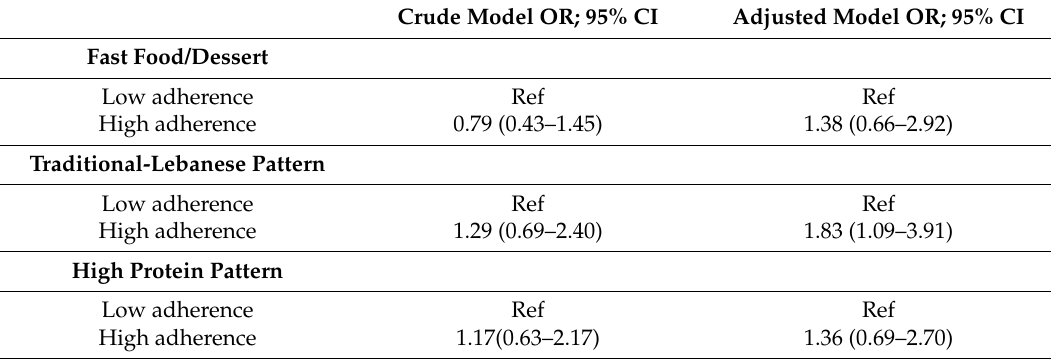
Table 3. Crude and adjusted logistic regression models describing the association between the various dietary patterns and MHOv/O in the study population, as derived by logistic regression ( n = 196) * ,†